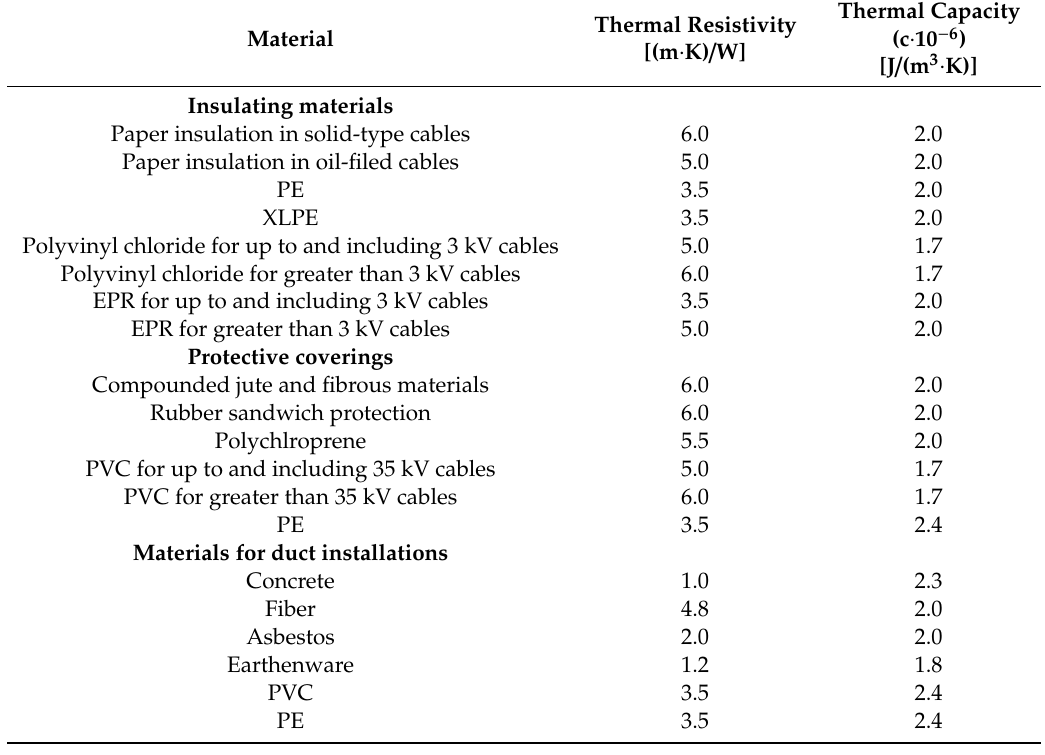
Table 2. Values of thermal resistivity and thermal capacity for some materials [10].